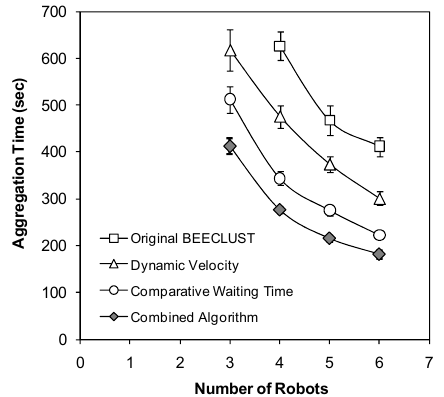
Fig. 13. Aggregation time for original BEECLUST and modified algorithms